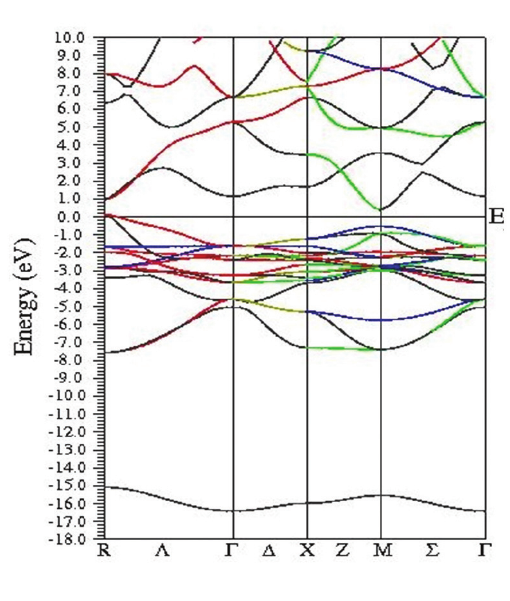
Figure 3. Band structure of Cu3N at the ground state by using GGA